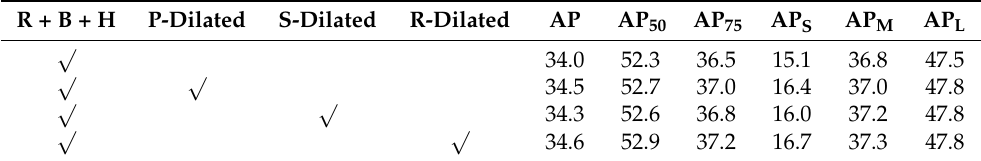
Table 5. Ablation studies of High-level Guided Model on COCO val-2017. B + R + D: RetinaNet + BidiFPN +